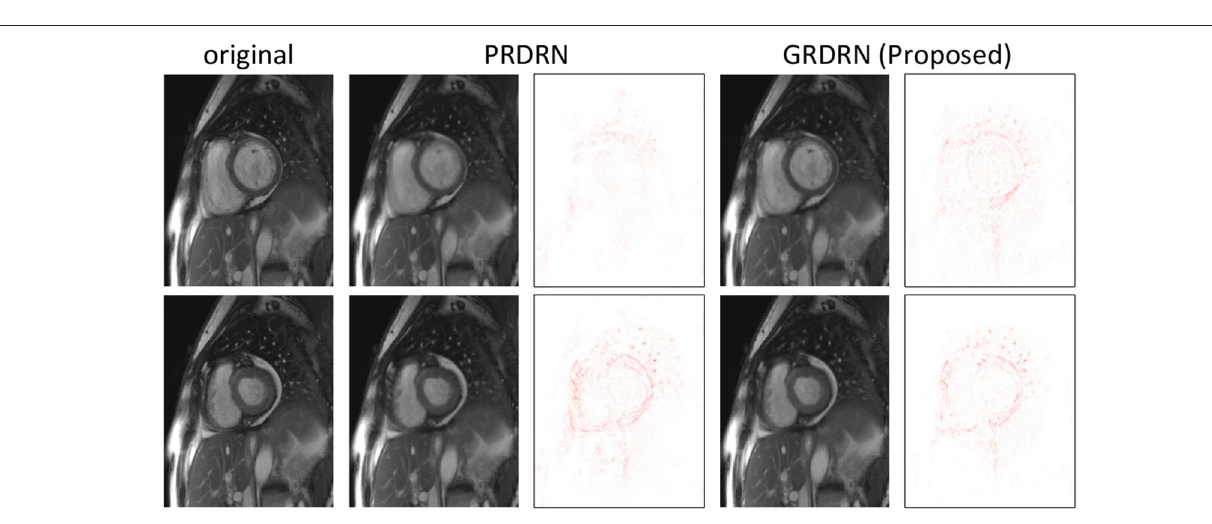
dynamic images. The joint motion estimation and